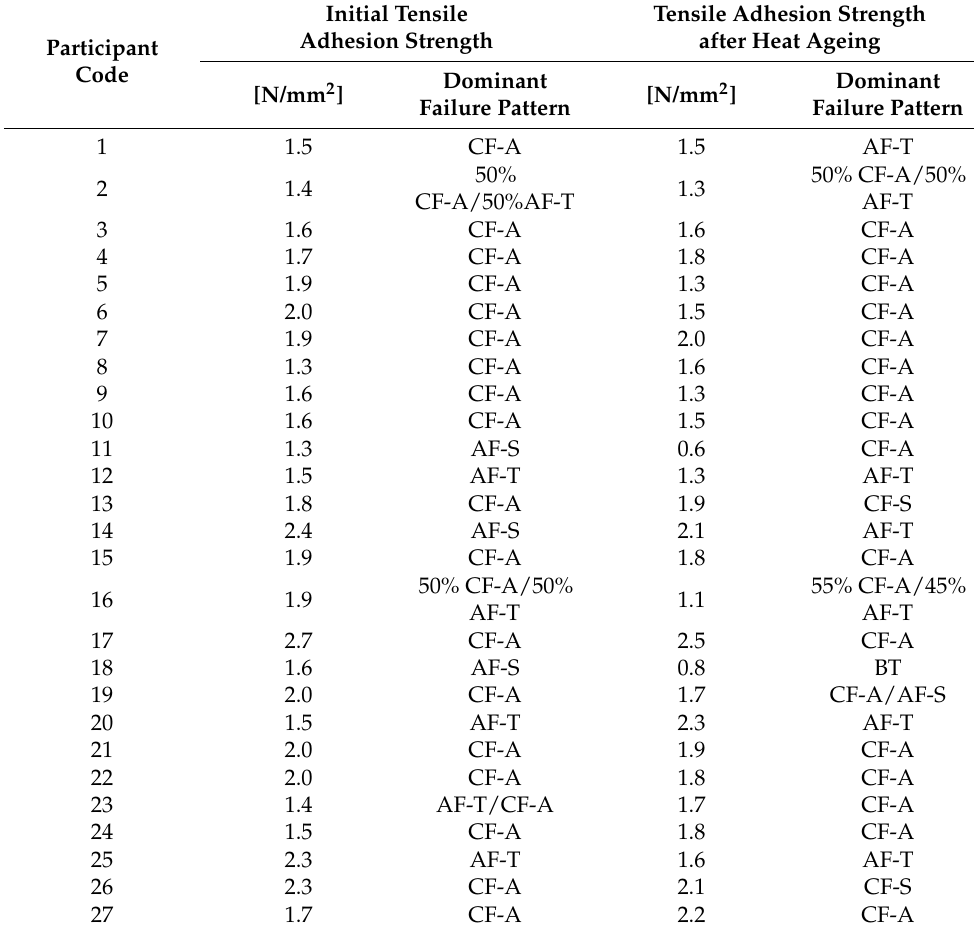
Table 1. The initial tensile adhesion strength and tensile adhesion strength after heat ageing of CTA with the predominant mode of failure obtained by 27 laboratories (participant codes from 1 to 27) in the 12th ed. of ILC.